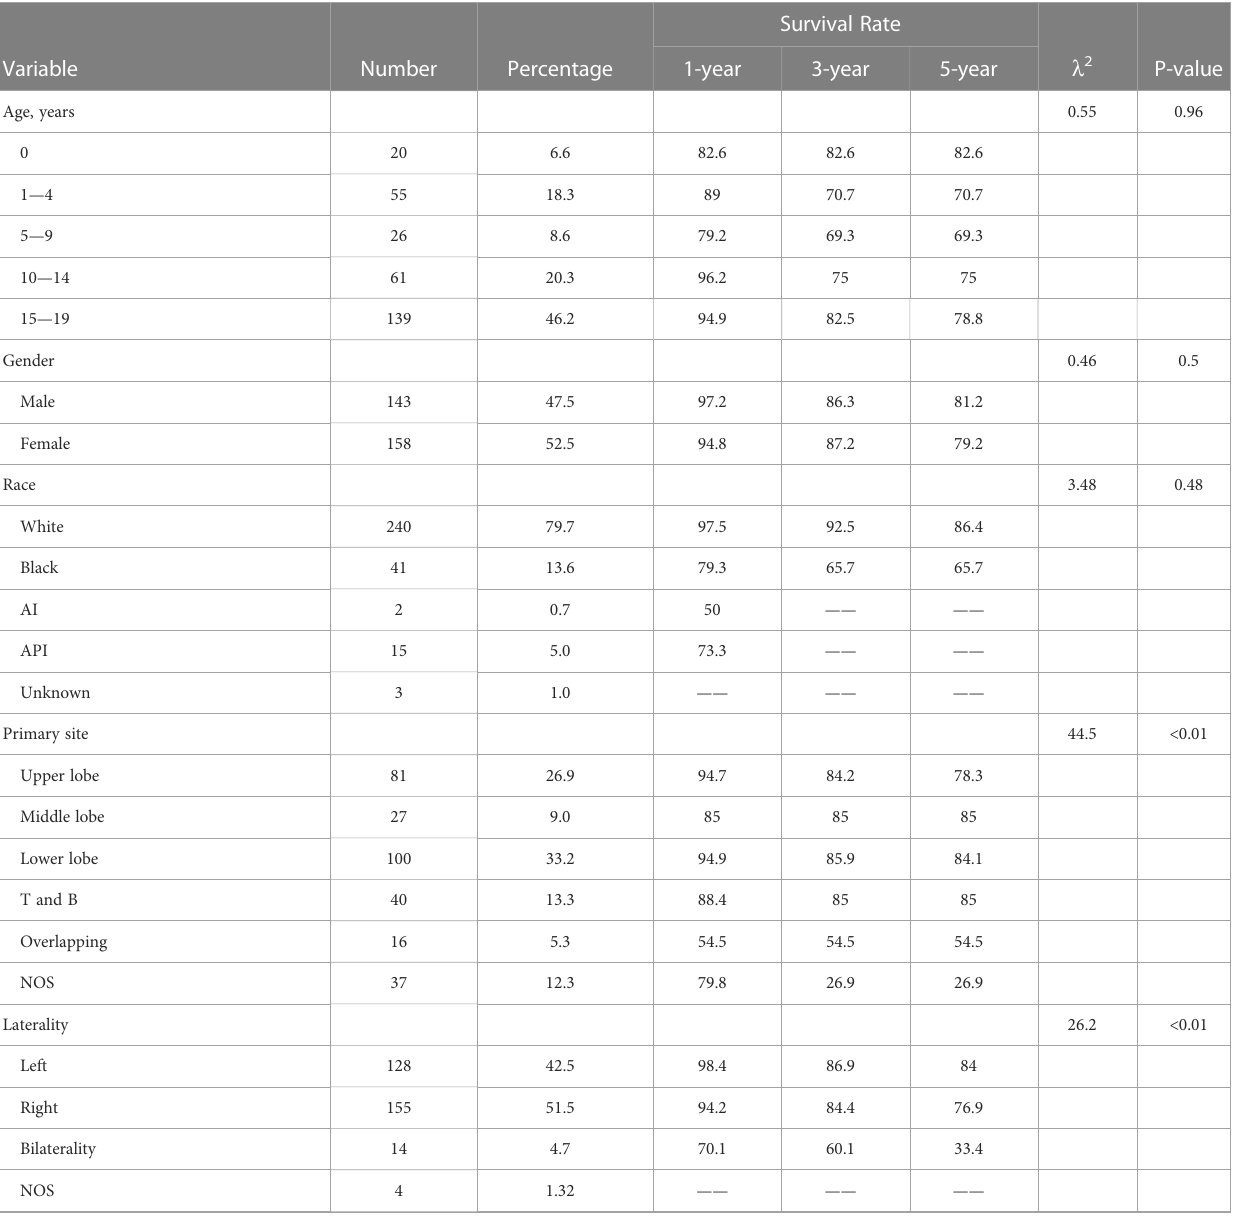
TABLE 1 Demographics, Clinical Characteristics, and